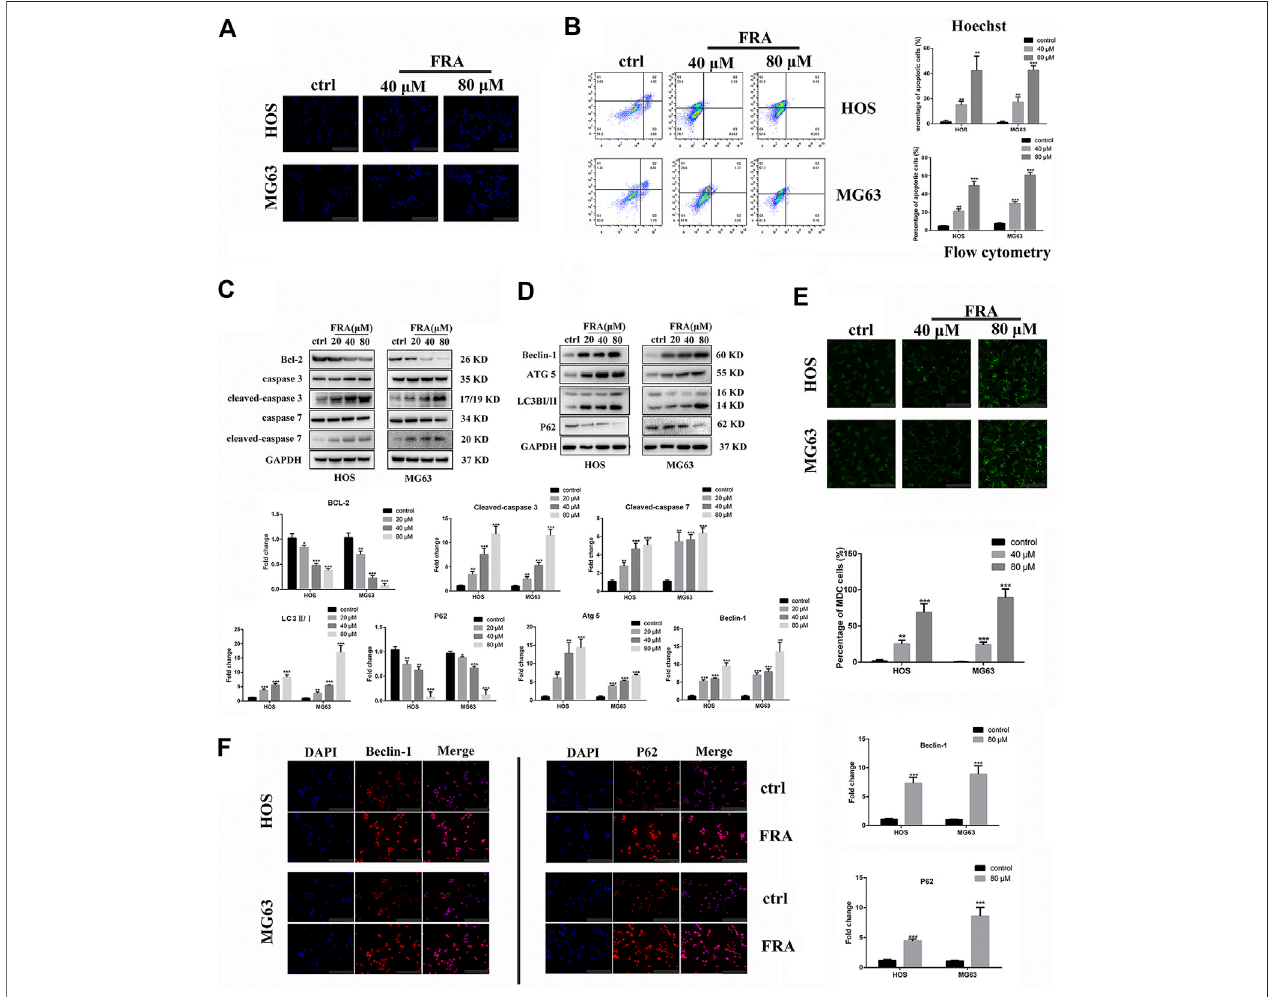
FIGURE3| FRAinducesautophagy and apoptosis ofosteosarcomacells invitro . (A) CellstreatedwithdifferentconditionswerestainedwithHoechst 33342,and results showed that the percentage of apoptotic cells in the FRA group was higher than in the control group. The highlight dots mean apoptotic cells. (B) After staining with an Annexin FITC/PI kit, the treated cells were tested by fl ow cytometry. The results indicated that the percent of total apoptotic cells signi fi cantly increased in the FRA-treated group in a dose manner. (C) The expression of the following apoptosis-related proteins was determined by Western blot analysis: Bcl-2,cleaved- caspase 3, caspase-3, cleaved − caspase 7, and caspase 7. (D) The expression of those autophagy-related proteins: Beclin-1, ATG5, LC3B and P62. (E) Cells treated with different conditions were stained with MDC, and results showed that the number of autophagosome in the FRA group was higher than in the control group. The green dots mean autophagosome. (F) The HOS and MG63 osteosarcoma cell lines were incubated with FRA (80 μ M) or control for 24 h. The expression level of the Beclin-1 and P62weresigni fi cantlyincreasedafter FRAtreatmentdetected viaimmuno fl uorescenceassays.Each assaywasrepeated threetimes. Magni fi cation, × 200 (A) , × 1000 (D) , × 200 (F) .Scalebar,100 μ m (A) ,20 μ m (E) ,100 μ m (F) .Errorbar (cid:2) mean ± SDofatleasttriplicateexperiments.* p < 0.05,** p < 0.01,*** p < 0.001versus